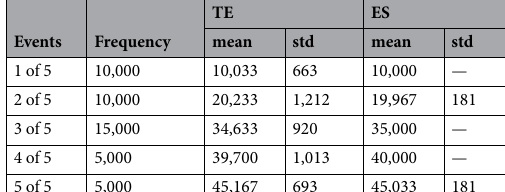
Table 3. Predicted leadership switching time in the Vicsek model for multiple events at different frequencies.